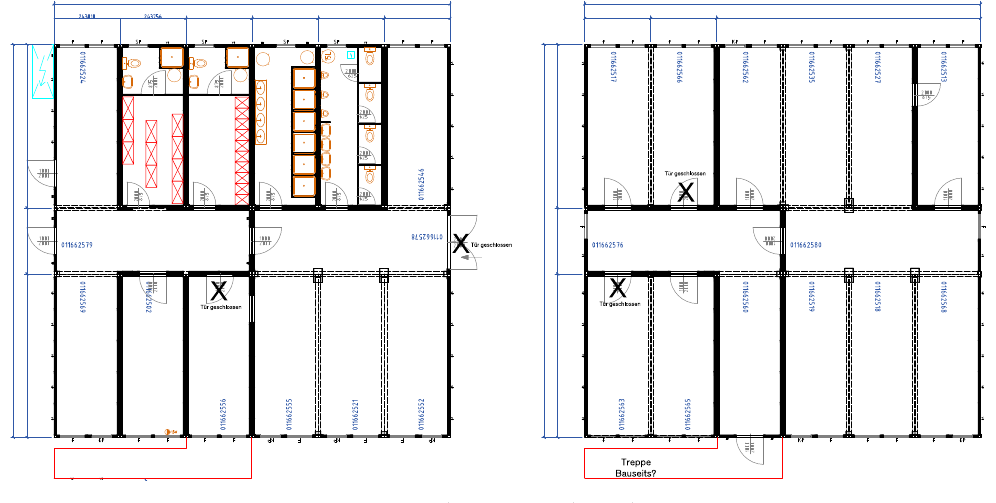
Figure 15. Pilot project: Floor plans.